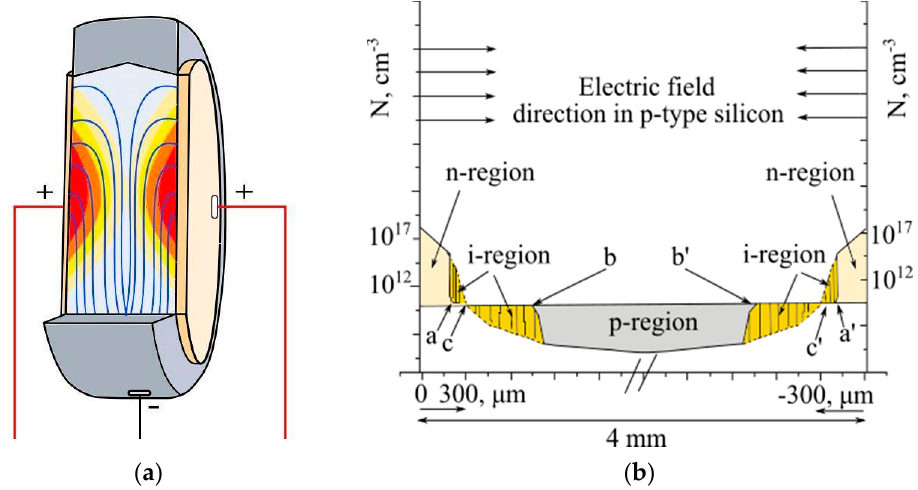
Figure 4. ( a ) Electric field distribution in the detector during the drift process, and ( b ) distribution of lithium-ions through the cross-section profile of the silicon crystal during the double-sided drift process.